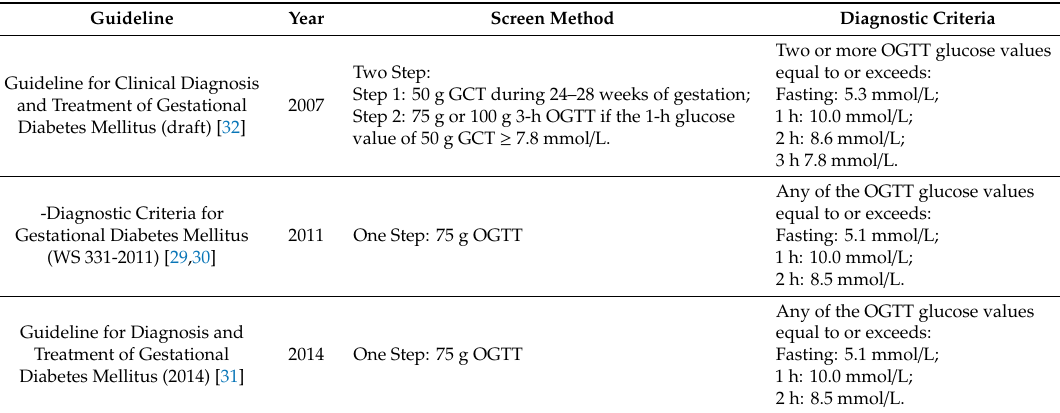
Table 2. Guidelines for diagnosis of GDM in China.